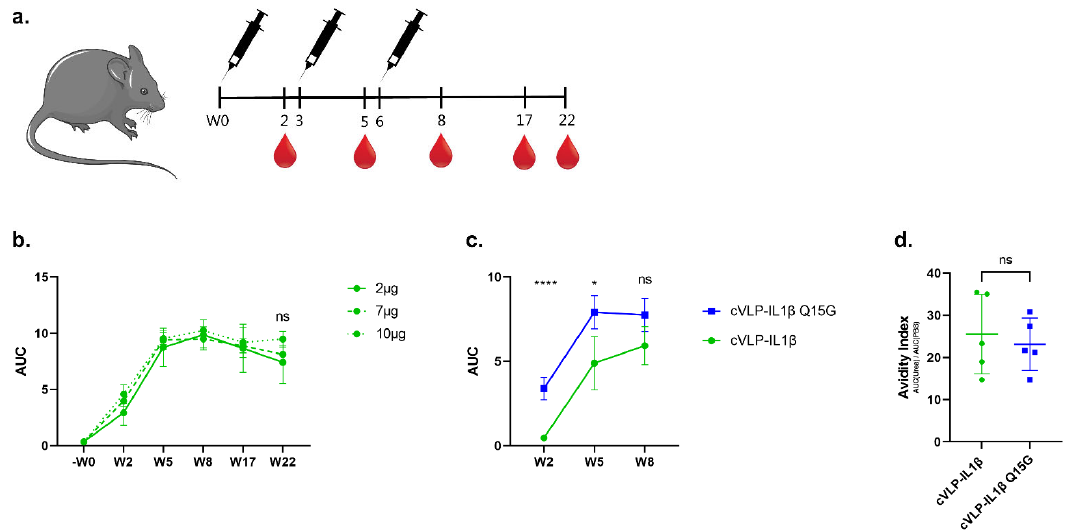
Figure 4. cVLP:IL-1 β vaccines induce antigen-specific autoantibody responses in mice. ( a ) Schematic outline of the vaccine immunogenicity study, including time points for vaccinations and blood sampling. Serum samples were collected from female C57BL/6 mice two weeks after each immunization in a three ‐ week interval prime ‐ boost ‐ boost (W0 ‐ W3 ‐ W6) regimen. For the initial antigen dose-escalation study, additional serum samples were collected at W17 and W22. ELISA results are depicted as the area under the curve (AUC) with mean ± standard deviation (SD). ( b ) Anti-IL-1 β IgG titers measured before ( − W0), and at different time points (weeks 2, 5, 8, 17, and 22) after vaccination are depicted as AUC values for groups of mice ( n = 4) vaccinated with 2 µ g (full line), 7 µ g (dashed line) or 10 µ g (dotted line) of cVLP-displayed IL-1 β . ( c ) Anti-IL-1 β IgG titers (AUC) measured in serum from mice ( n = 5) vaccinated with the cVLP:IL-1 β (green) and cVLP:IL-1 β Q15G